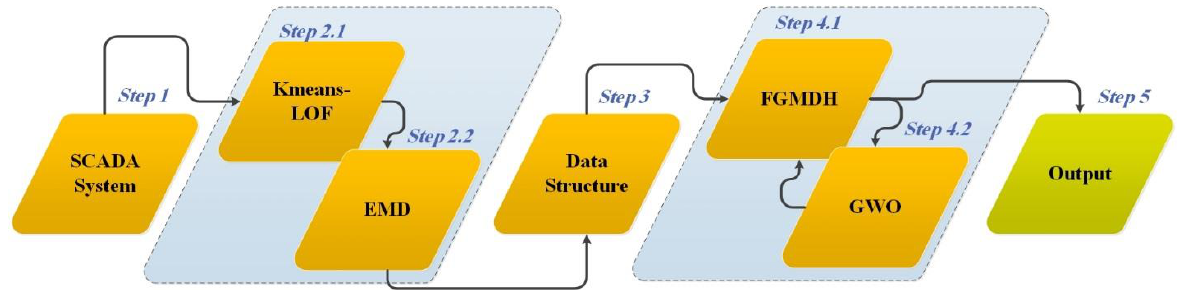
Figure 1. General schematic of the proposed forecasting model.